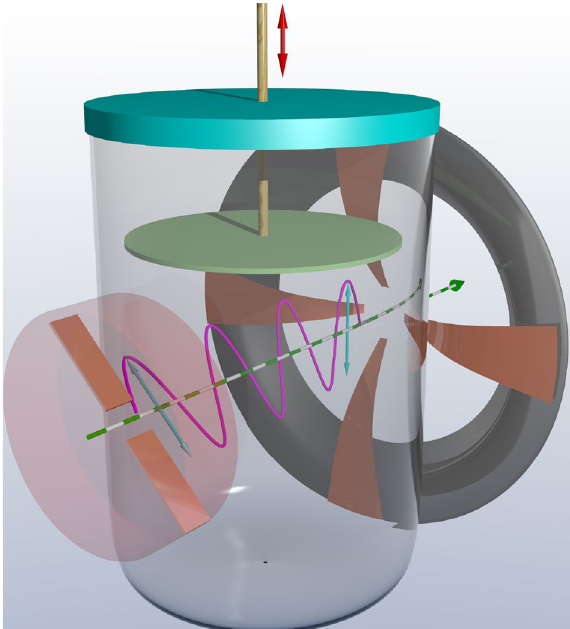
Figure 3. The experimental setup scheme. A shortened transmitting antenna (surrounded by a radar-absorbing case on the sides) is on the left, while a receiving slot antenna with QAM is on the right. The shift between the antennas polarization is 45 ◦ .